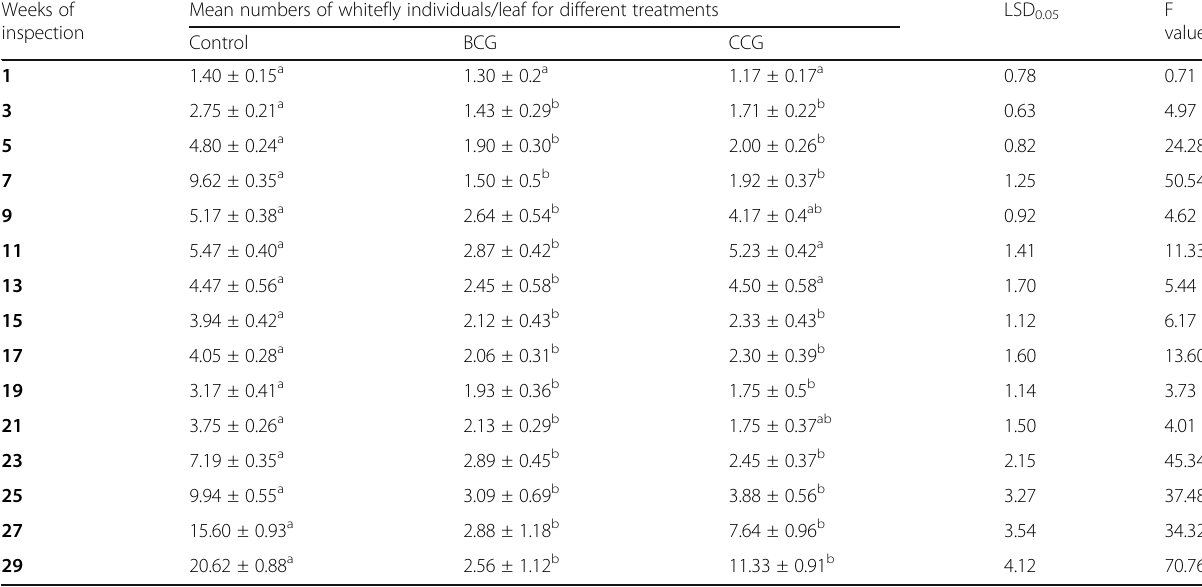
Table 3 Mean counts of whitefly individuals/leaf on sweet pepper leaves in the greenhouse during the winter plantation of 2016/17 Weeks of Mean numbers of whitefly individuals/leaf for different inspection